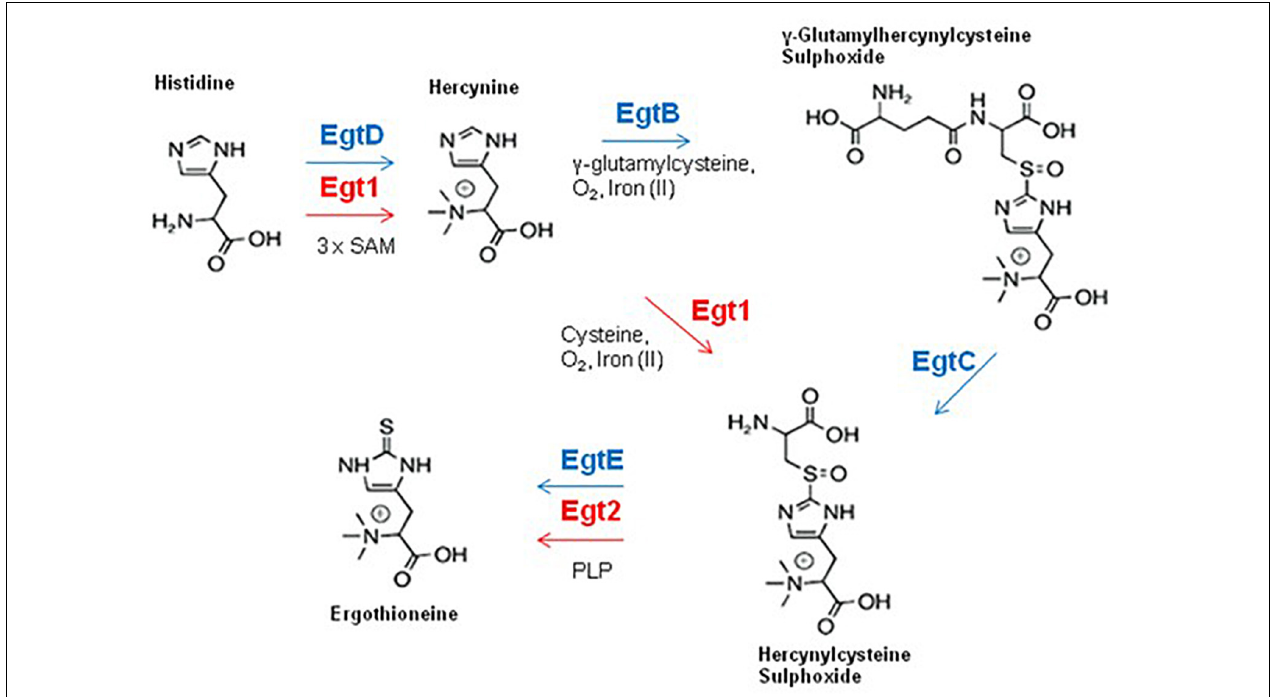
FIGURE 4 | EGT biosynthesis in fungi and bacteria. Fungal enzymes are shown in red, bacterial enzymes are shown in blue. The fungal EGT pathway contains a maximum of two enzymes, uses cysteine as a sulfur source and does not produce the intermediate γ -glutamyl hercynylcysteine sulphoxide (Note Egt-1 = EgtA).